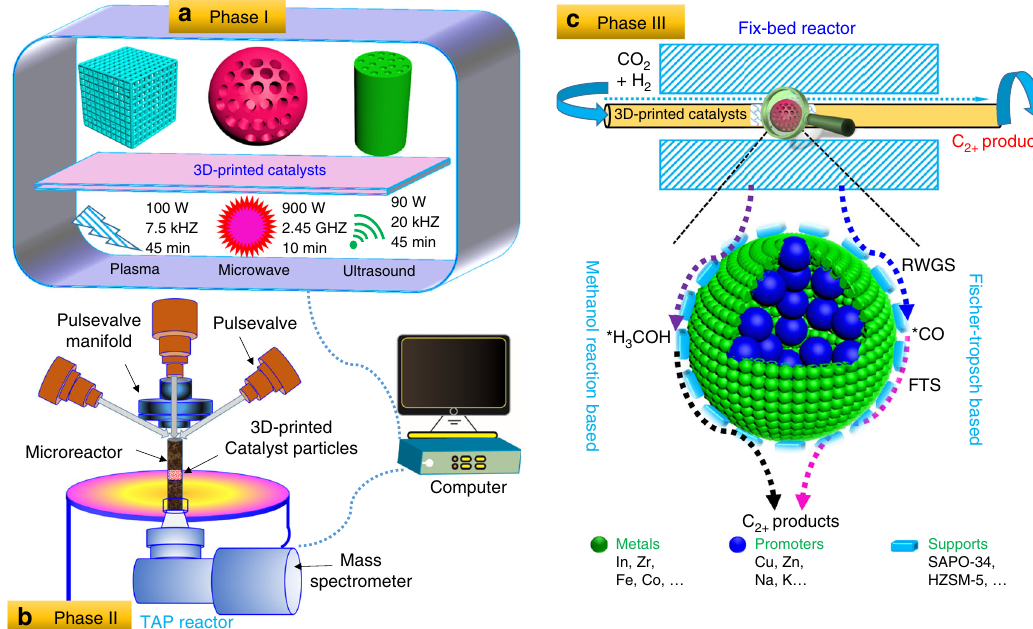
Fig. 5 Scheme of AI-guided development of CO 2 hydrogenation catalysts. Phase I is to prepare and modify catalysts using 3D printing technologies and new material modi fi cation technologies, such as plasma, microwave, and ultrasound modi fi cation 135,137,138 . Phase II is to use advanced techniques to characterize the catalysts. Phase III is to perform AI-guided evaluation of the